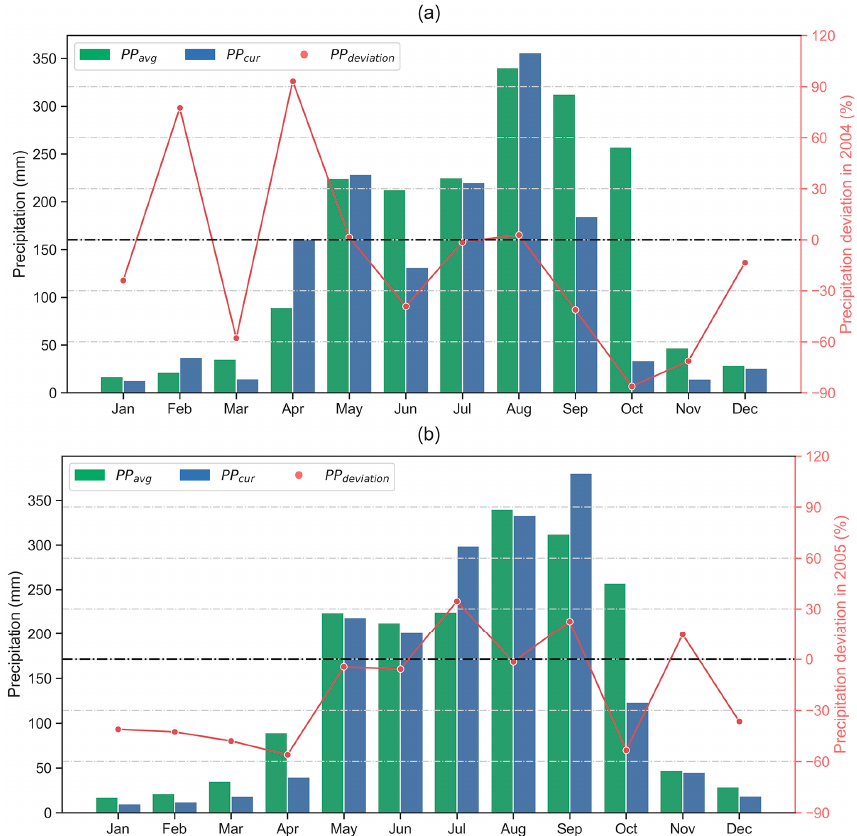
Figure 11. Monthly rainfall in 2004–2005 and its deviations from the 40-year average monthly rainfall on Hainan Island: ( a ) 2004 and ( b ) 2005. Results were analyzed using data from the Climate Hazards Group InfraRed Precipitation with Station (CHIRPS) on the GEE platform. ( PP avg : average precipitation 1981–2021, PP cur : current year rainfall, PP deviation : precipitation deviation).